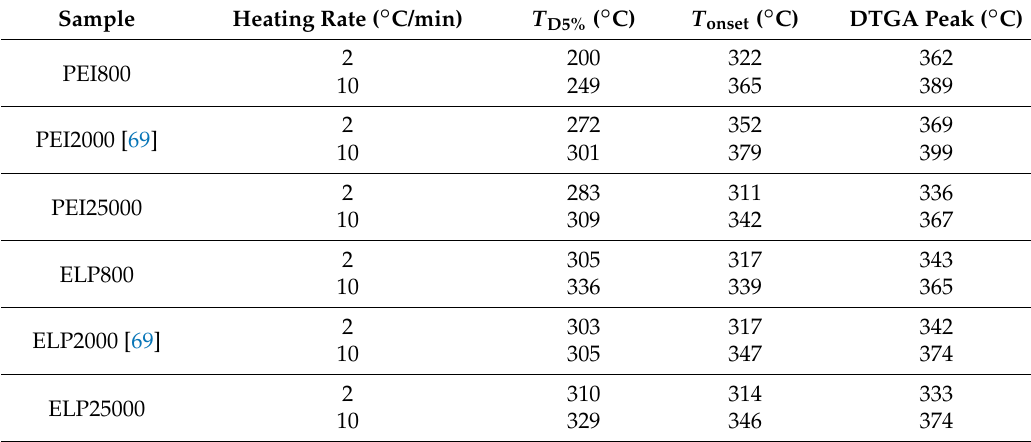
Table 1. Results of the analysis of thermal degradation of the samples studied. The degradation temperatures are evaluated as: temperature of 5% weight loss, T D5% ; the onset temperature, T onset ; the peak temperature of the DTGA